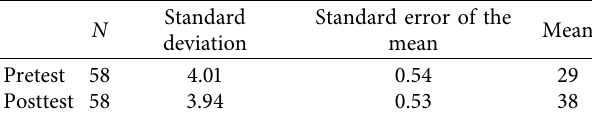
Table 3: Paired-sample statistics.